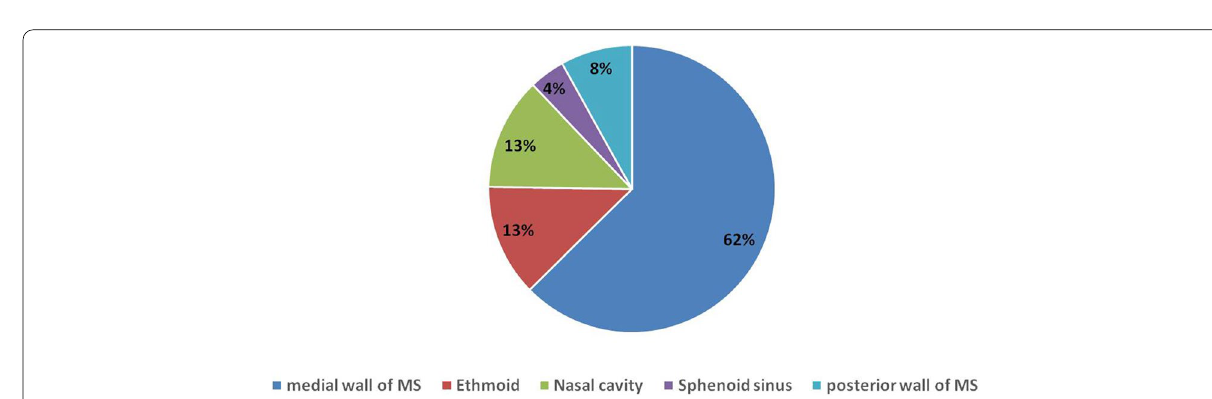
Fig. 6 Origin sites of IP according to surgical